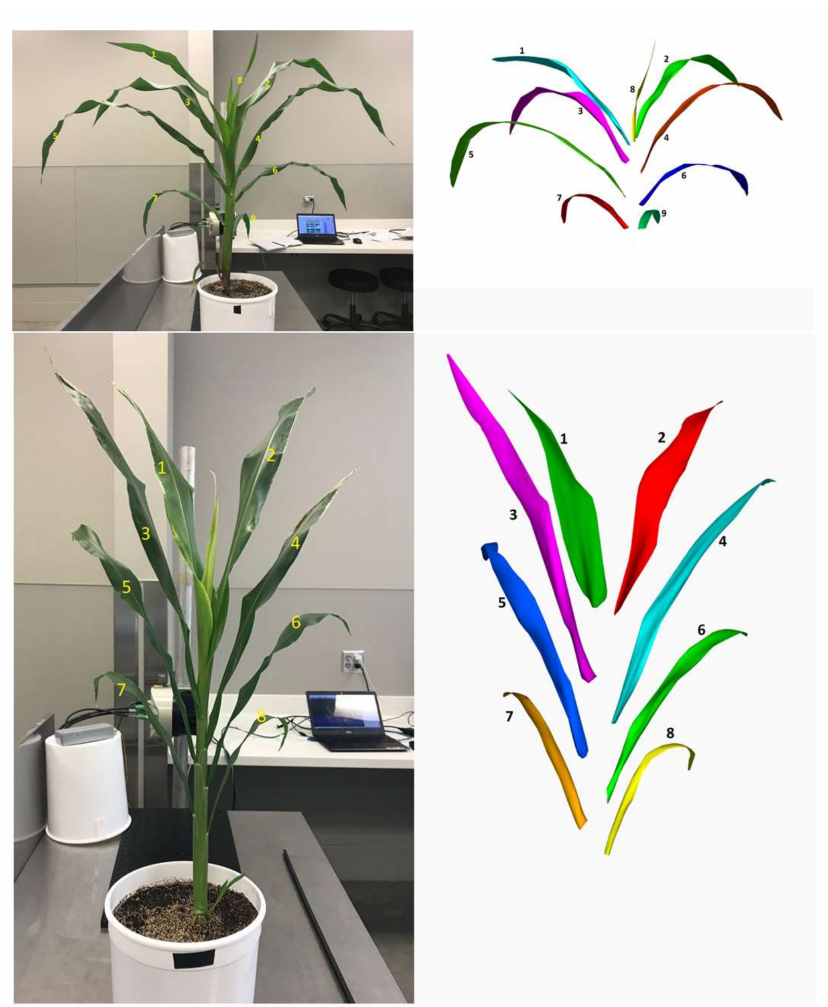
Figure 5. Side-by-side comparison of the RGB image of a maize and a sorghum plant and their 3D models obtained by the new instrument. The segmented individual leaves are labeled (1 through 9 for maize, and 1 through 8 for sorghum) sequentially for easy